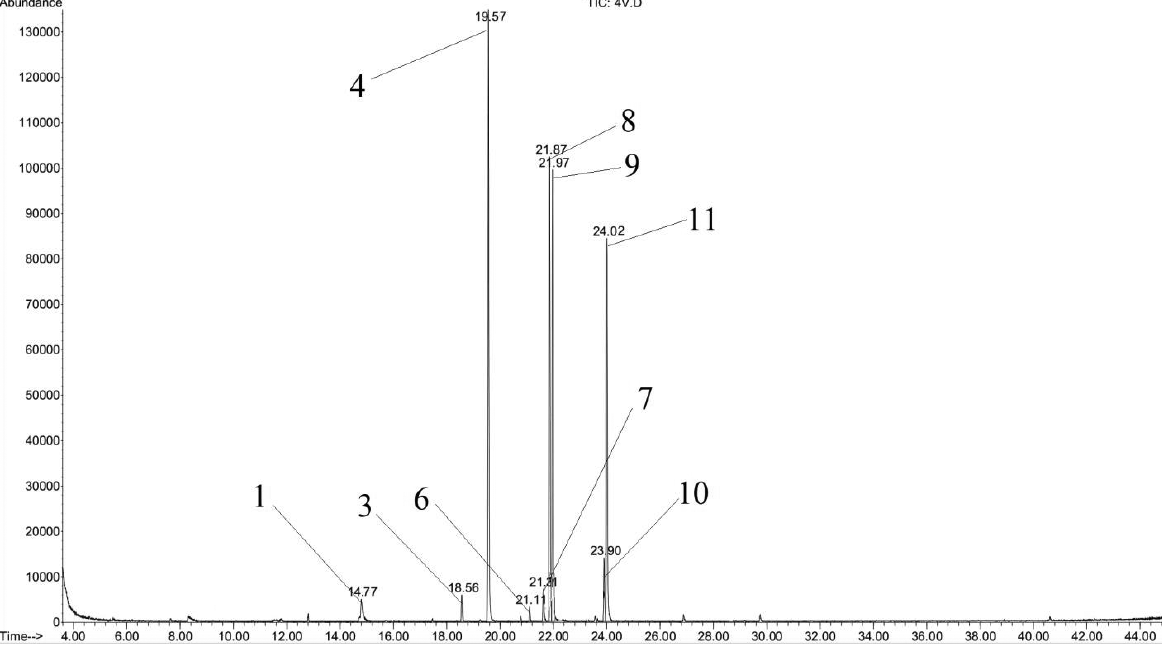
Figure 3. GC-MS chromatogram of free amino acids in the sample 2 of the plant mixture.